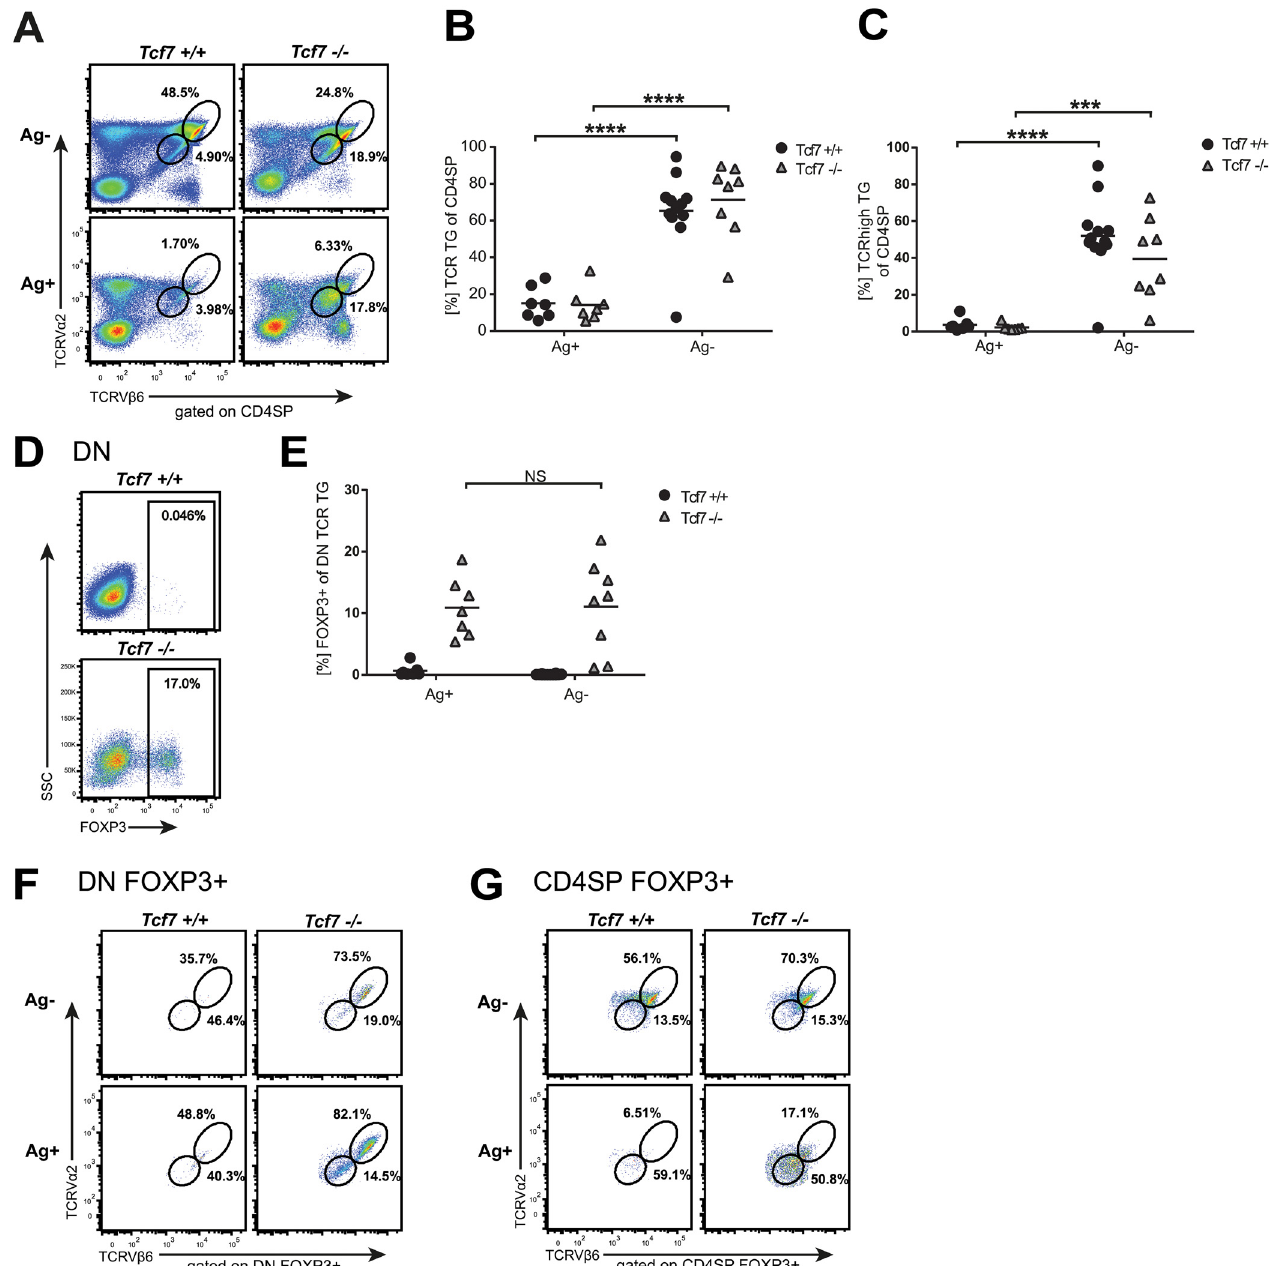
Fig 2. Analysis of Foxp3 + DN cells in TEa-Tcf7-deficient mice. (A) Representative plots showing TCRV β 6 and TCRV α 2 expression on CD4SP thymocytes from TEa-Tcf7 +/+ and TEa-Tcf7 -/- mice in the presence or absence of cognate antigen (Ag). The Tg TCR population is divided into TCR high and TCR low populations. (B-C) Quantification of the percentage of total (B) or TCR high (C) TCRV β 6 + TCRV α 2 + cells among CD4SP thymocytes (n = 8). (D) Representative plots showing Foxp3 expression in DN TCRV β 6 + TCRV α 2 + thymocytes from TEa-Tcf7 +/+ and TEa-Tcf7 -/- mice in the absence of Ag. (E) Quantification of Foxp3 + DN TCRV β 6 + TCRV α 2 + thymocytes from TEa-Tcf7 +/+ and TEa-Tcf7 -/- mice in the presence or absence of Ag (n = 8). (F-G) Representative plots showing TCRV β 6 and TCRV α 2 expression on DN Foxp3 + (F) or CD4SP Foxp3 + (G) thymocytes from TEa-Tcf7 +/+ and TEa-Tcf7 -/- mice in the presence or absence of Ag. Cells are pre-gated on TCRV β 6 + TCRV α 2 + . Each dot represents one individual animal and mean is shown for all quantified data. Numbers show percentages of cells within the indicated box. NS, not significant, *** P < 0.001, **** P < 0.0001 (unpaired t-test).